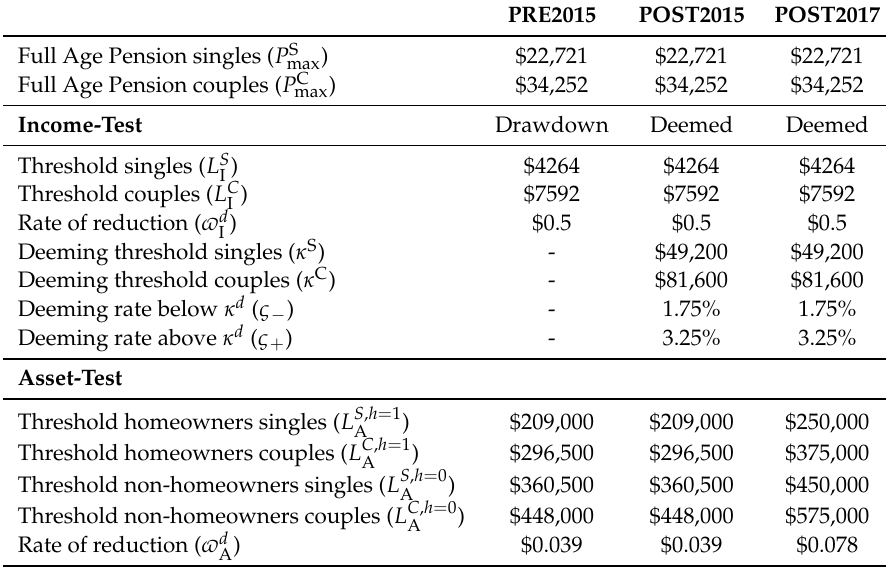
Table 1. Age Pension rates, thresholds and taper rates used in the means-test for each policy